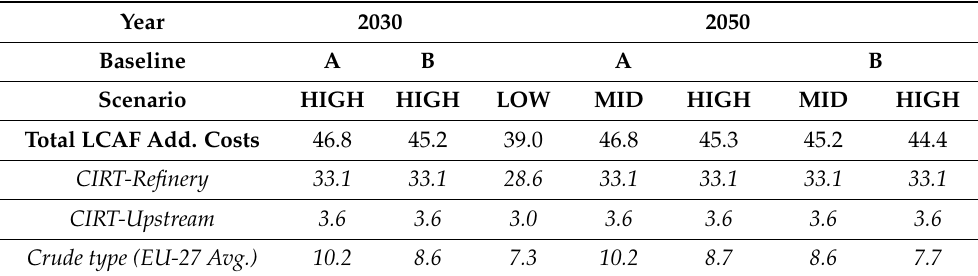
Table 6. LCAF projected costs for the seven scenarios exhibiting LCAF potential, when using the free-allocation method